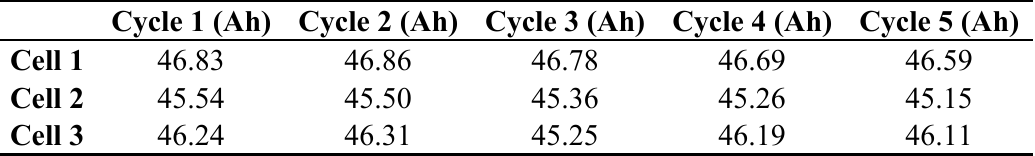
Table 2. Pre-conditioning test results LFP batteries 40